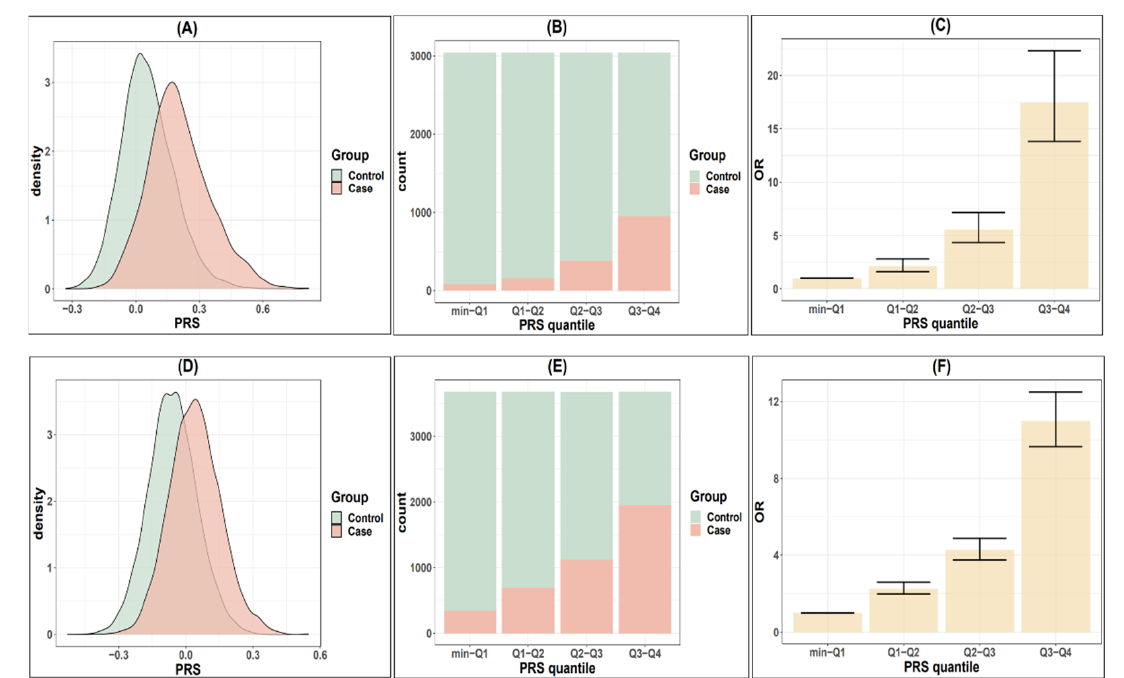
Figure 2. Comparison of cataract risks in TWB2.0 classified by PRS quantile. ( A ) Distribution of the polygenic risk score (PRS_younger) in younger cataract cases (<60) and controls. ( B ) Distribution of younger cases and controls according to PRS_younger quantiles. ( C ) Odds ratio for developing cataract in younger population according to PRS_younger quantiles. ( D – F ) are the cataract risks classified by PRS_older in older populations ( ≥ 60 years old).